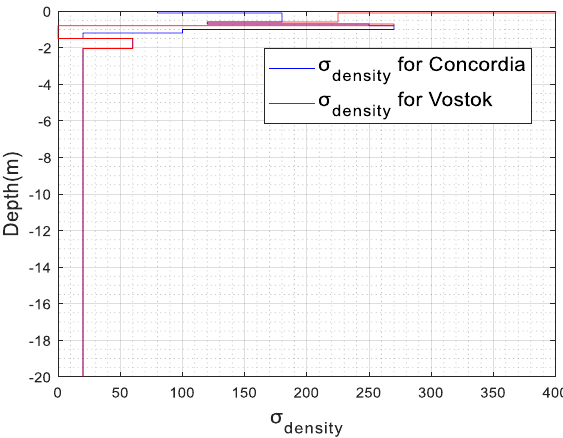
Figure 15. 𝜎 𝑑𝑒𝑛𝑠𝑖𝑡𝑦 profiles at Concordia and Vostok Stations to match calculated and measured brightness temperatures. Note the differences near the surface.